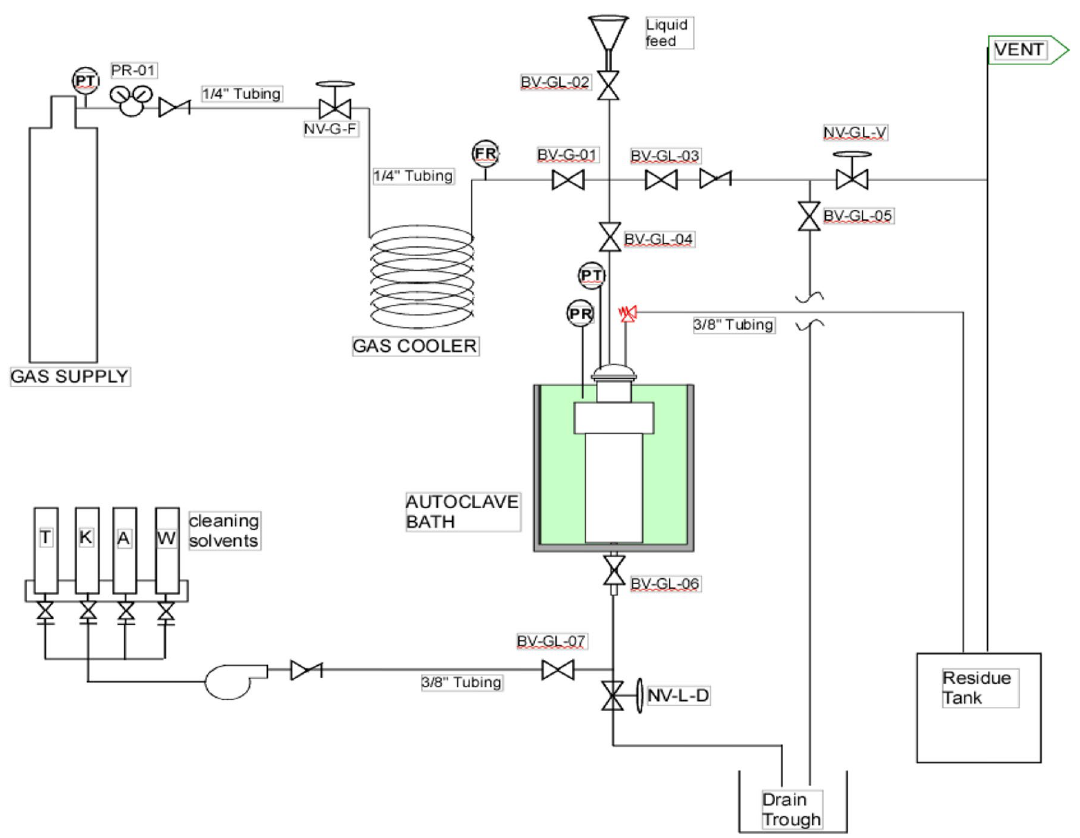
Fig. 8 P&ID for the mixer-viscometer setup